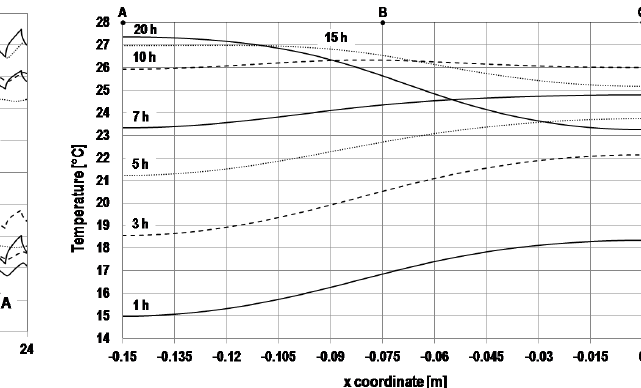
Figure 5: Temperature profiles at the selected points of the model of a floor heater.